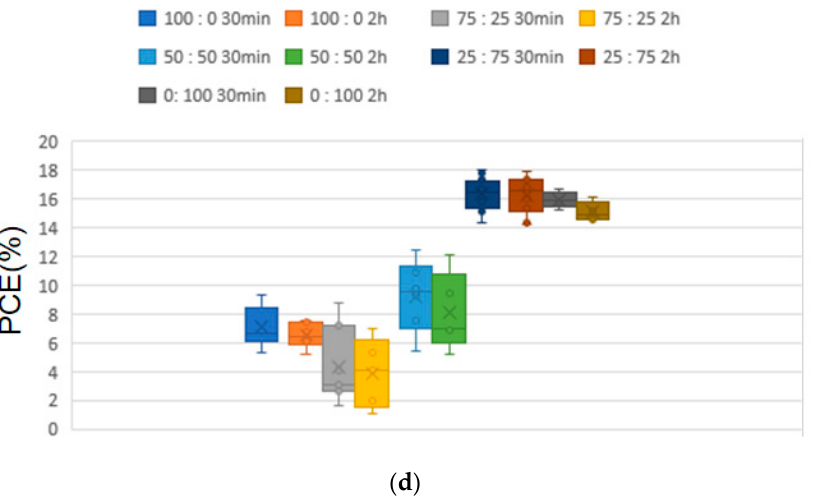
Figure 9. Distributions of I–V parameters of ( a ) V oc , ( b ) J sc , ( c ) FF, and ( d ) PCE. All the data were obtained from each solar cell fabricated using the 10 different ETLs.